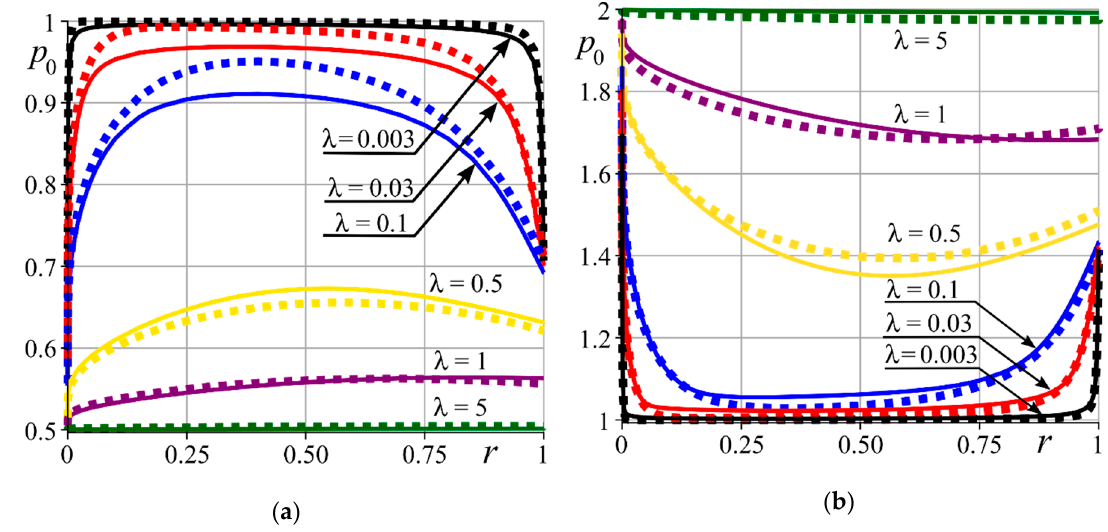
Figure 10. Relative contact pressure for the coatings of different relative thickness λ calculated with N >> 1 (solid lines) and N = 1 (dotted lines): ( a ) β = 0.5; ( b ) β = 2.